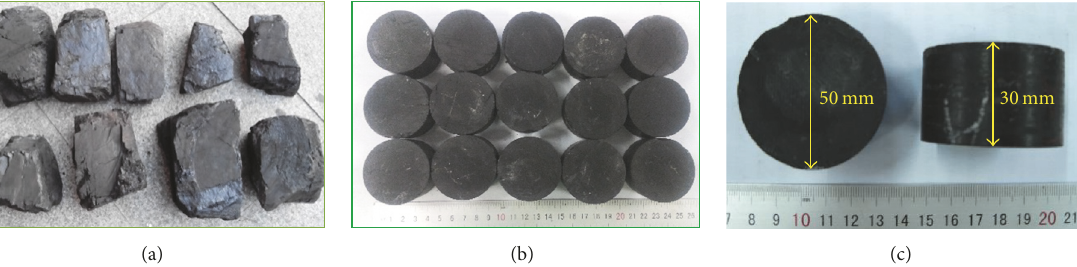
Figure 3: Specimens for static and dynamic testing: (a) specimens before processing and (b) specimens after processing.